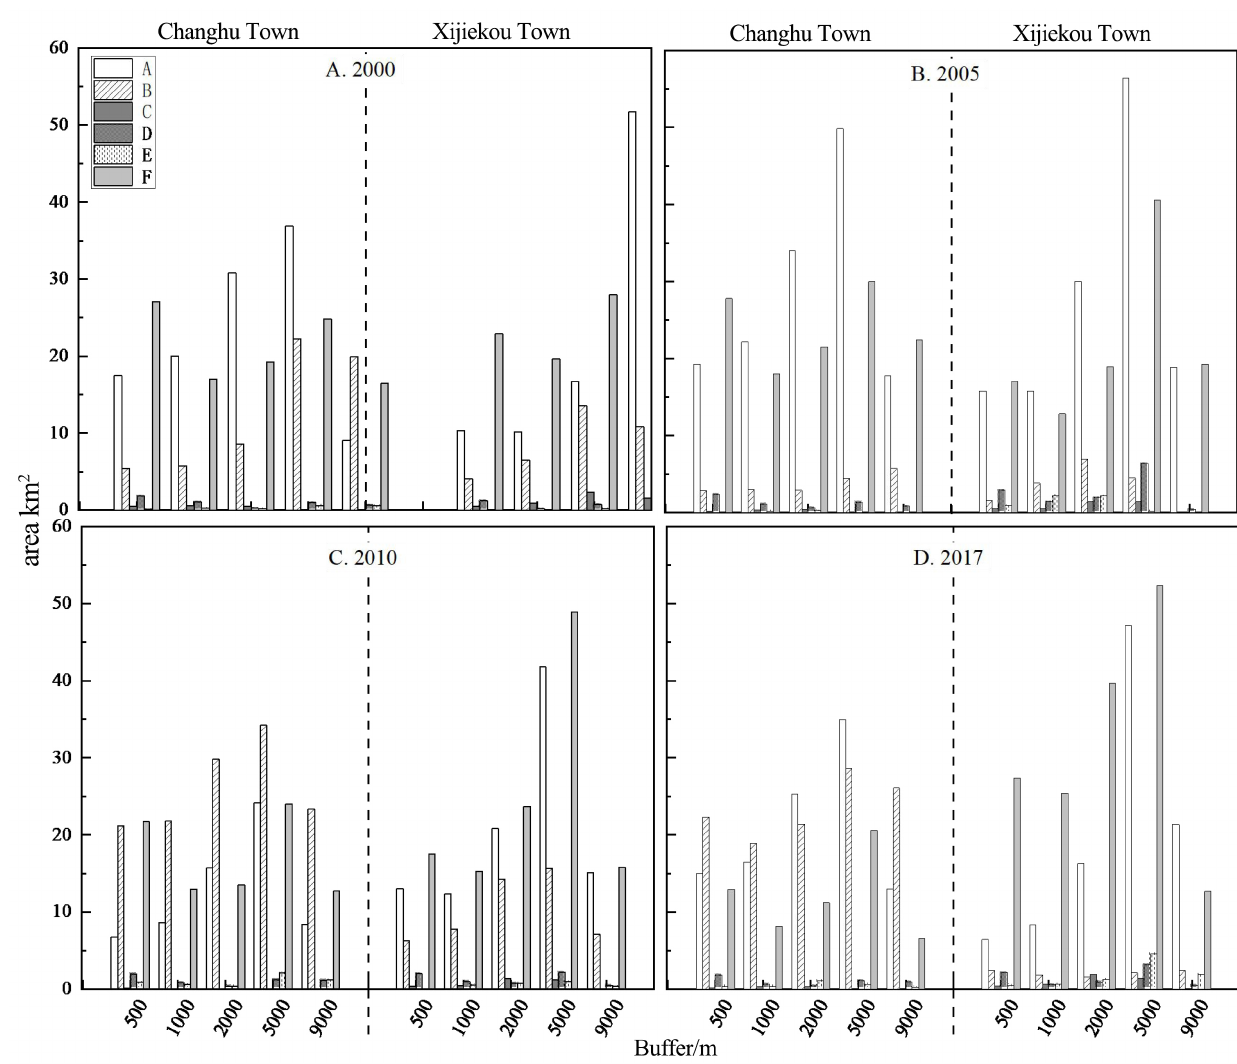
Figure 7. Land-use landscape composition of different buffers in the study area from 2000 to